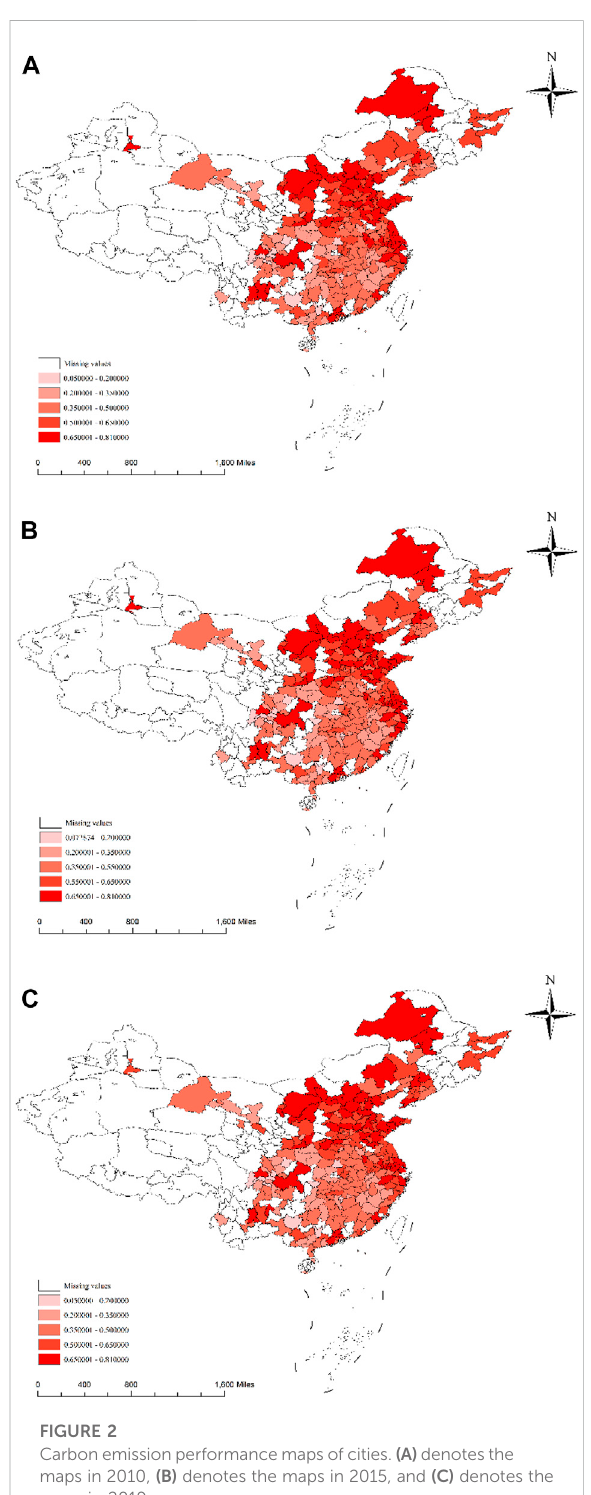
FIGURE 2 Carbonemission performancemapsofcities. (A) denotesthe maps in 2010, (B) denotes the maps in 2015, and (C) denotes the maps in